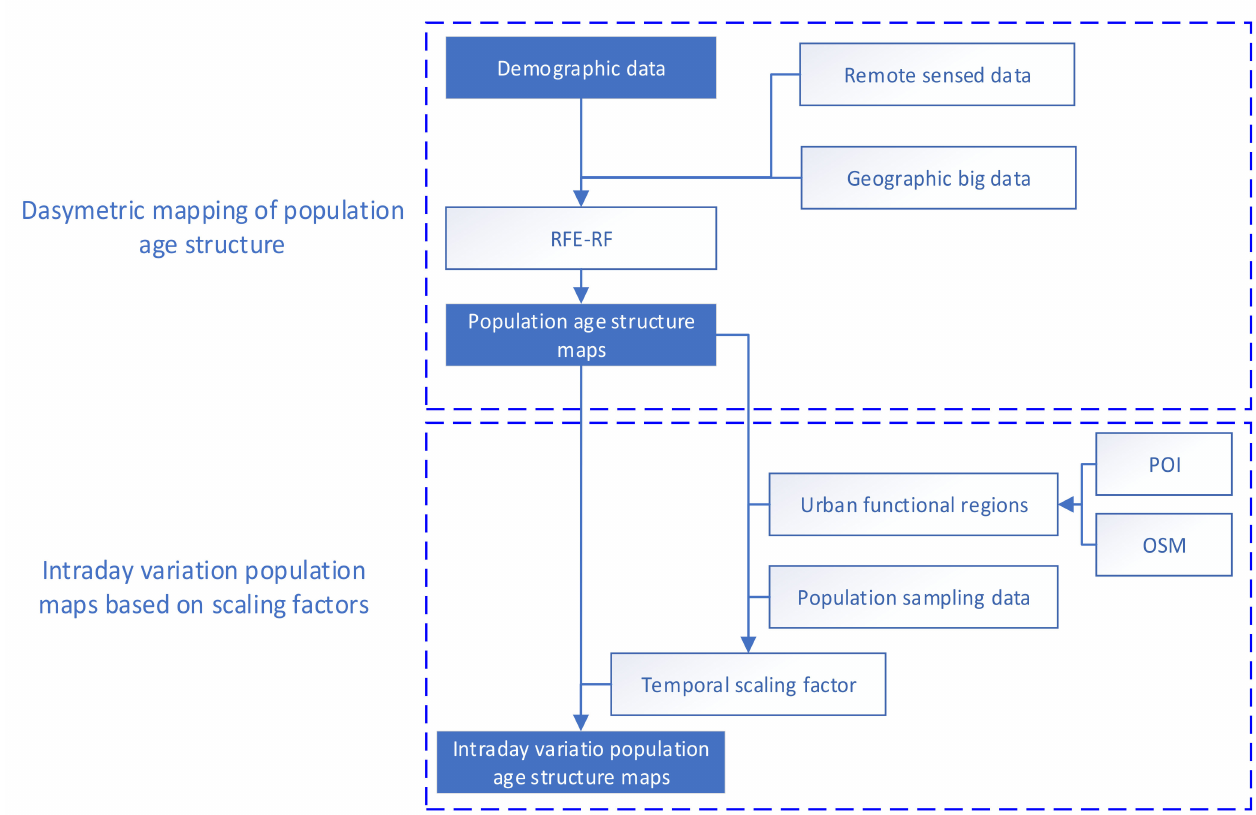
Figure 3. Diagram of the methodological framework of intraday variation mapping of population age